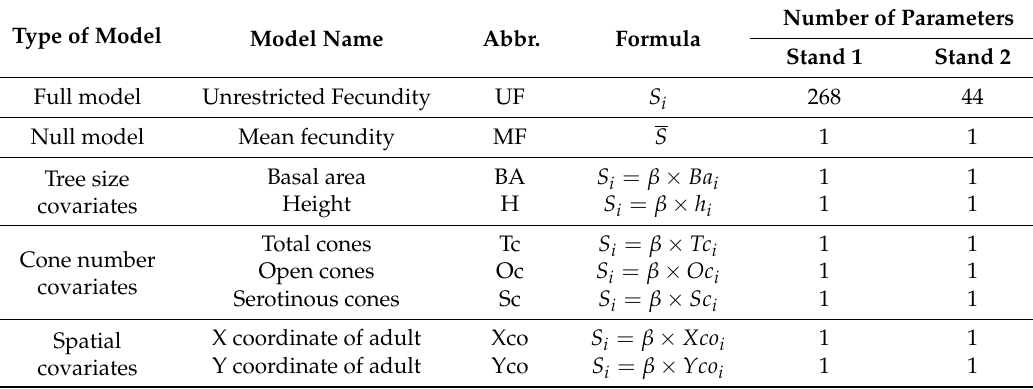
Table 1. Alternative models for the fecundity term of the seed shadow